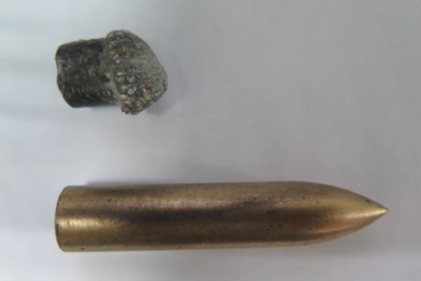
Figure 7: Residual projectiles after penetrating the C-RPC target at